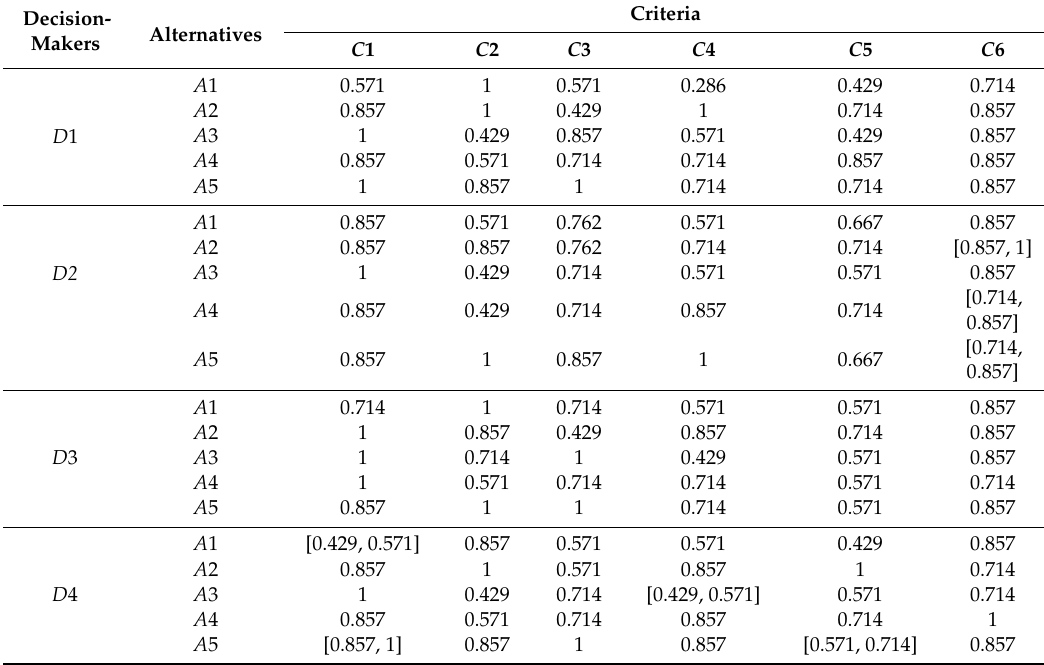
Table 4. Complete information of criterion rating values for alternatives.